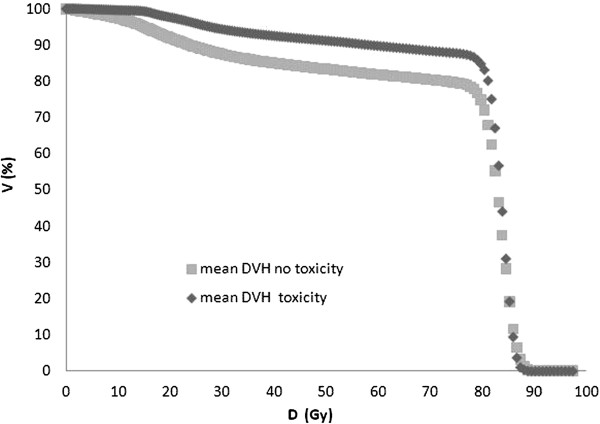
Mean dose volume histograms of the volume of rectum enclosed in the PTV for patients who did and did not experience late GI toxicity.